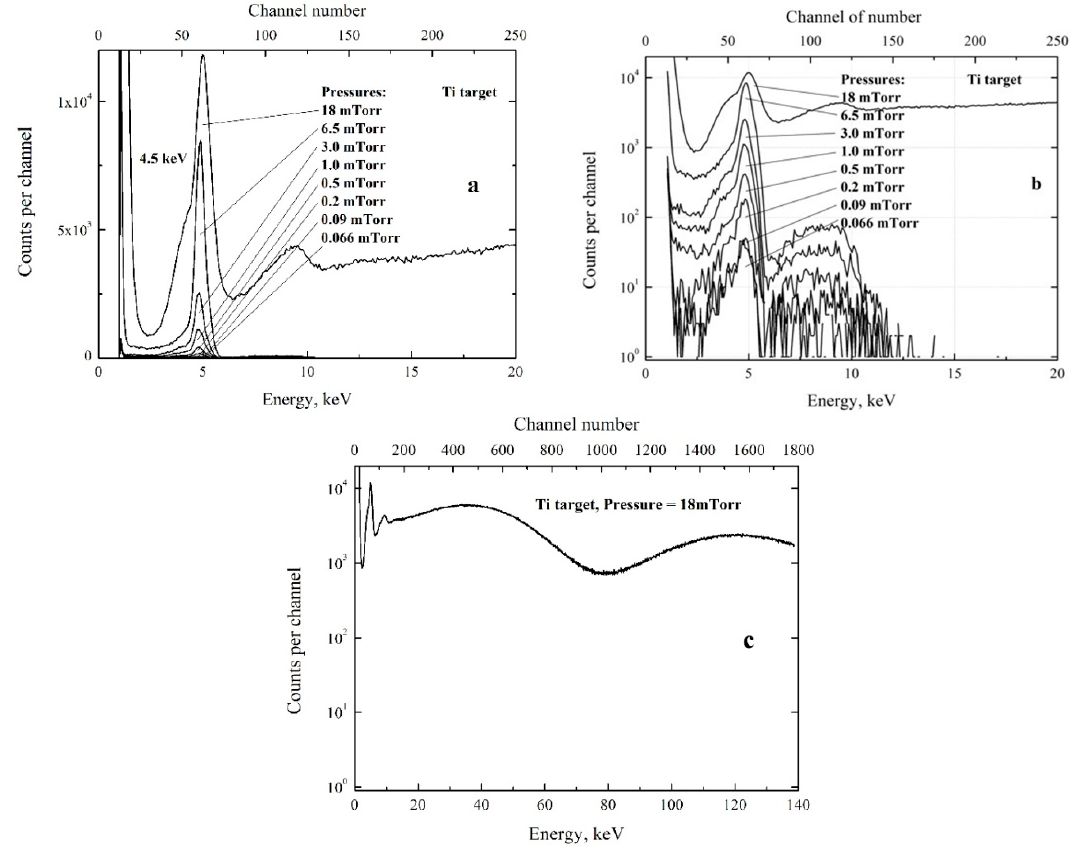
Figure 4. Spectra of X-ray radiation measured at different pressures P of the residual gas are shown in linear ( a ) and logarithmic ( b ) scales as functions of photon energy and corresponding number of channel of the spectrometer. The result of the measurement at P = 18 mTorr is shown separately in the extended energy range ( c ).